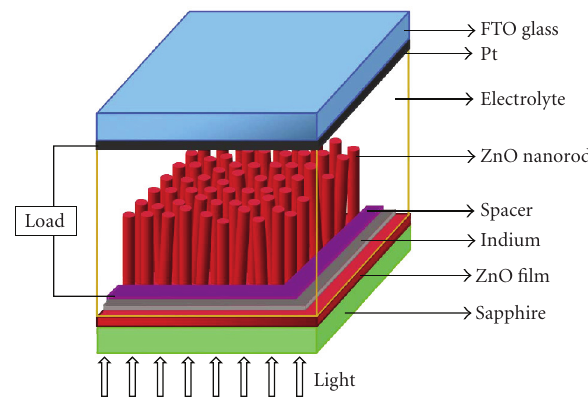
Figure 1: Schematic structure of the ZnO-nanorod dye-sensitized solar cell.